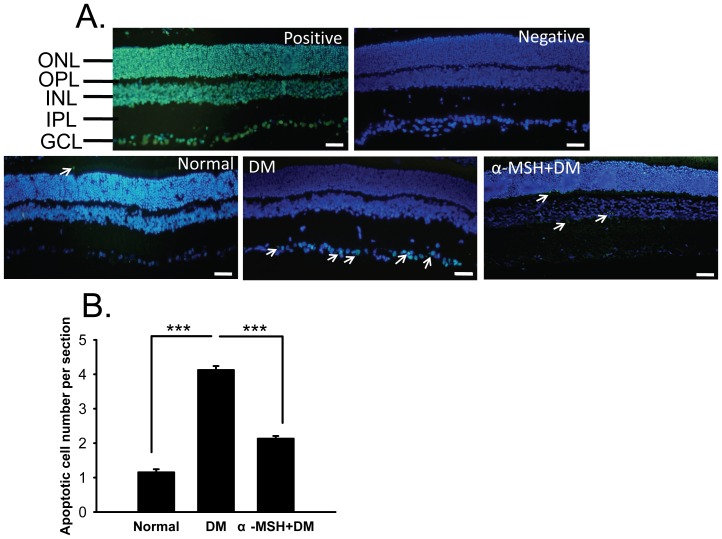
α-MSH significantly reduced the number of apoptotic cells in the neuroretina of diabetic rats.Retinal cryosections were subjected to TUNEL staining. The merged images of TUNEL staining and DAPI counterstaining are shown in (A). The positive and negative controls for TUNEL staining are shown in the upper panel of (A). Representative images for normal, DM and α-MSH+DM groups are shown in the lower panel of (A). The apoptotic cells are indicated by white arrows. The estimated representation of the number of apoptotic cells per section is shown in (B). n = 5–6/group, *** p<0.001. Scale bar, 50 μm.